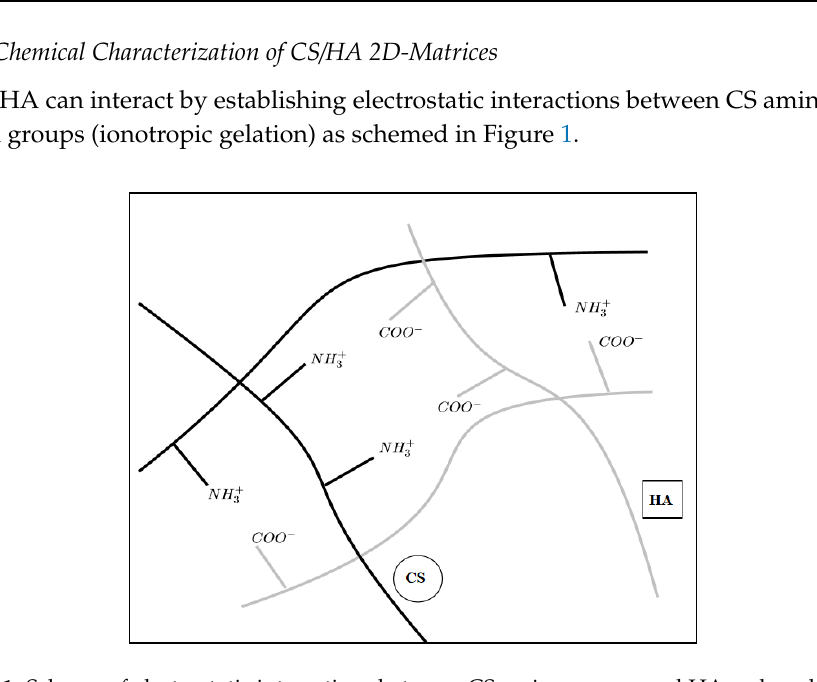
Figure 1. Scheme of electrostatic interactions between CS amino groups and HA carboxyl groups.